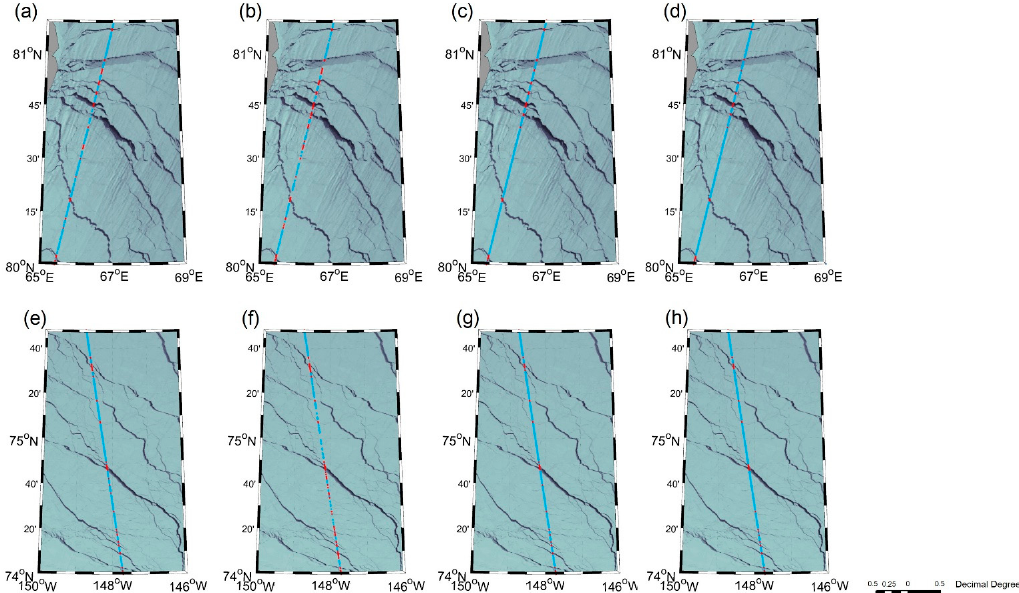
Figure 7. Examples of lead detection results around east Franz Josef Land on 11 April 2014 ( a – d ) and Beaufort Sea on 11 April 2011( e – h ) using four methods: ( a , e ) Rose [16]; ( b , f ) Laxon et al. [18]; ( c , g ) See 5.0 in the present study and ( d , h ) random forest in the present study. Red and blue dots represent leads and sea ice, respectively. Table 7. The error matrix based on the See 5.0-based lead detection results for IC.